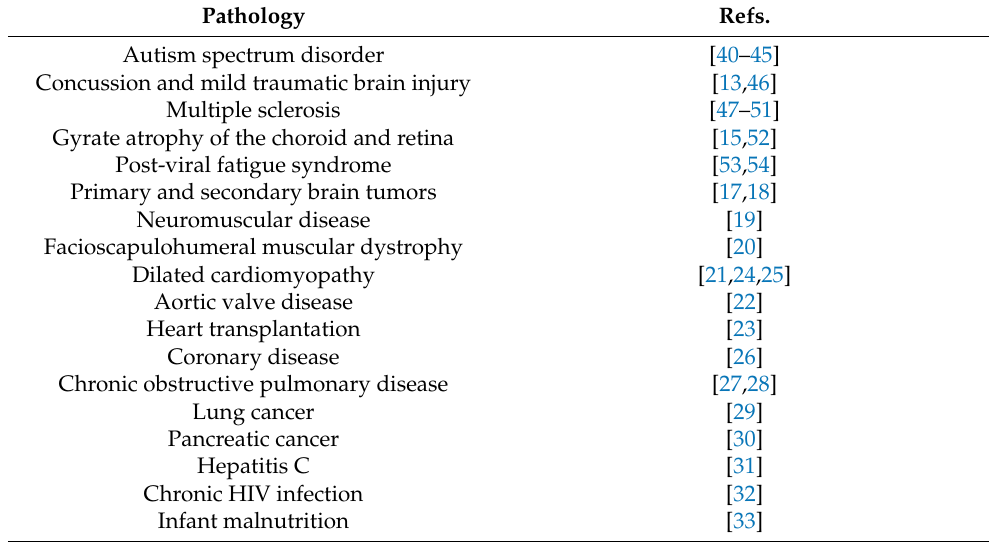
Table 1. Summary of human studies (excluding CCDS) describing low tissue creatine levels.